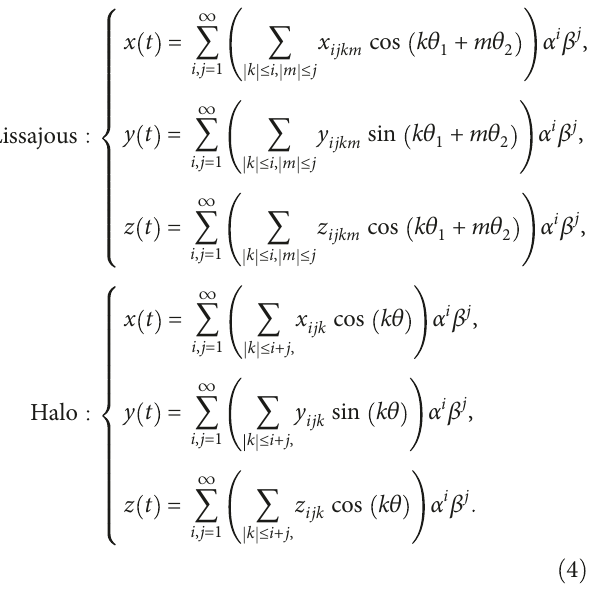
Figure 1: Equilibrium points of